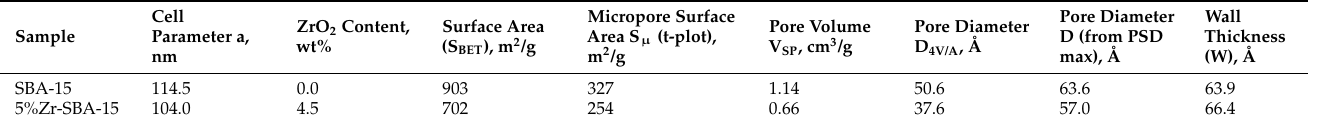
Table 1. Textural and structural properties and elemental composition of Zr-SBA-15